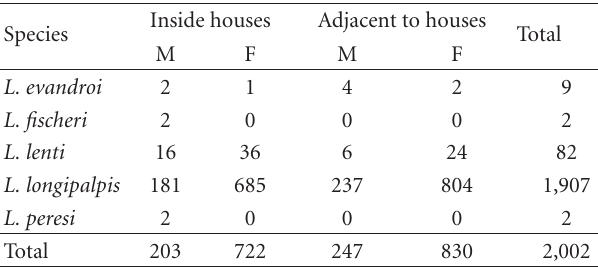
Table 2: Species of sand flies identified following sampling of